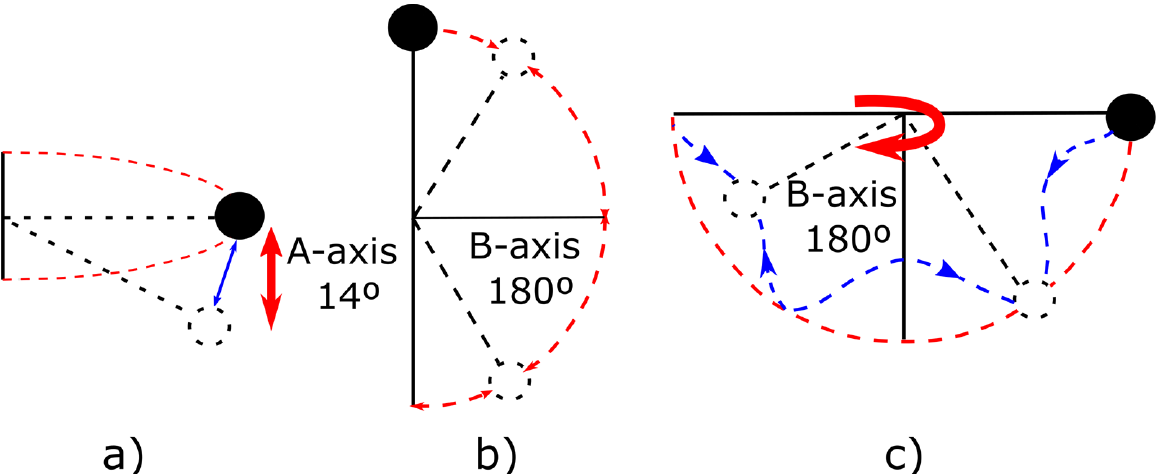
Figure 7. Motion around: ( a ) A, ( b ) B, and ( c ) A and B axes simultaneously.